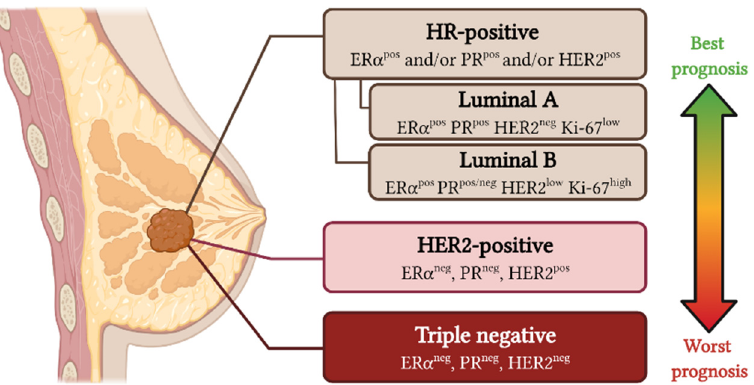
Figure 2. Molecular classification of breast cancer subtypes. Breast cancer can be divided into three main subtypes depending on the histological expression of four markers (ER α , PR, HER2, and Ki-67): hormone receptor (HR)-positive, HER2-positive, and triple-negative. This figure was created with Biorender.com (accessed on 12 December 2021).